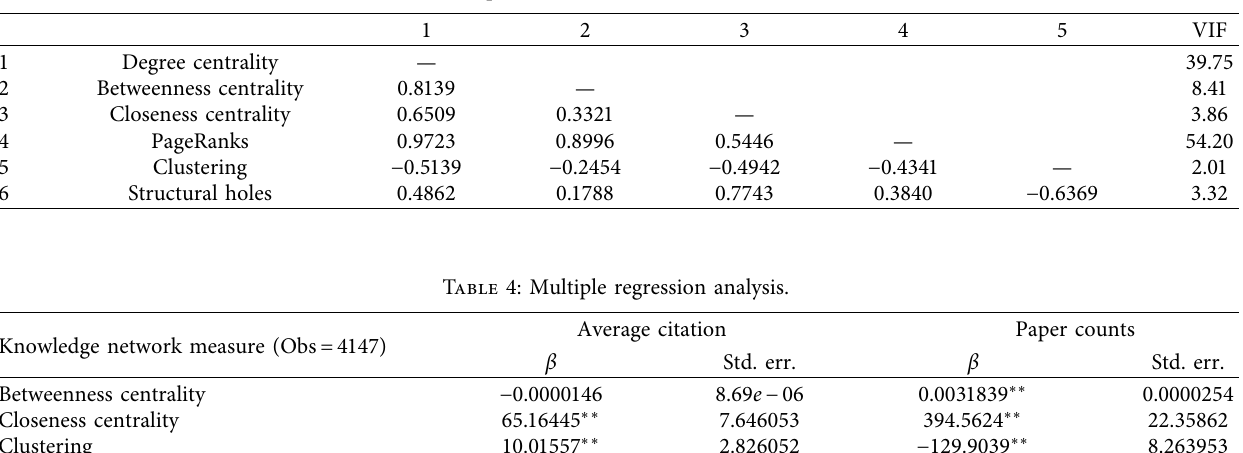
Table 3: Independent variable correlation test and VIF.